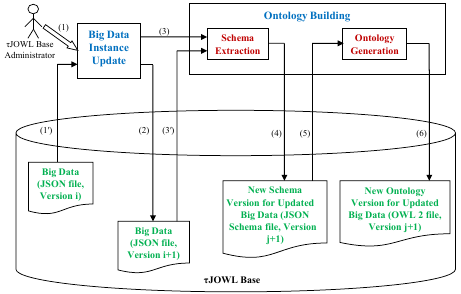
Fig. 6 The second part of the (cid:28)(cid:28)(cid:28) JOWL